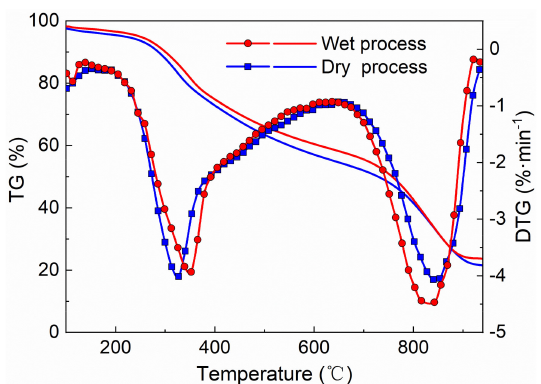
Figure 1. TG and DTG curves of the lignite and digestate mixtures blended by wet and dry